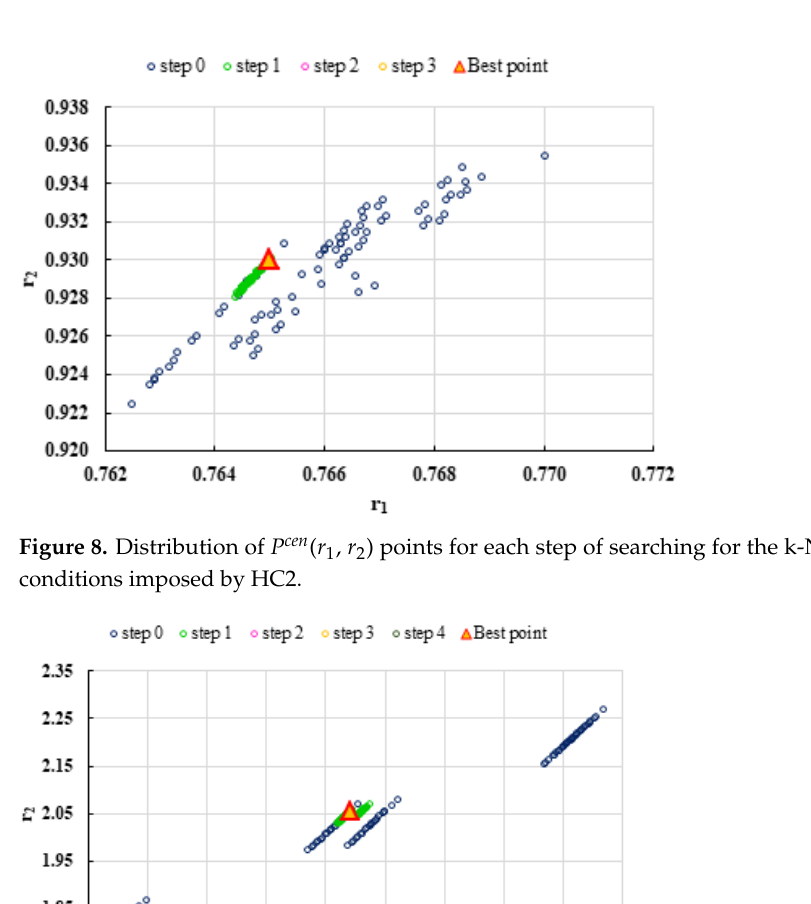
Figure 7. Distribution of P cen (r 1 , r 2 ) points for each step of searching for the k-NN method for the conditions imposed by HC1.